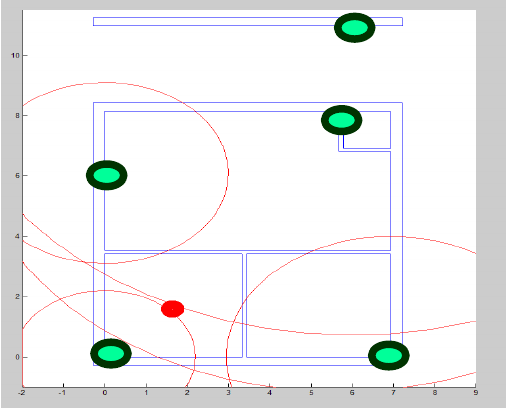
Figure 5. Test Bed for u-Life Care and deployment of Zio Access Point (WLB5254AP) to capture the location of subject (red